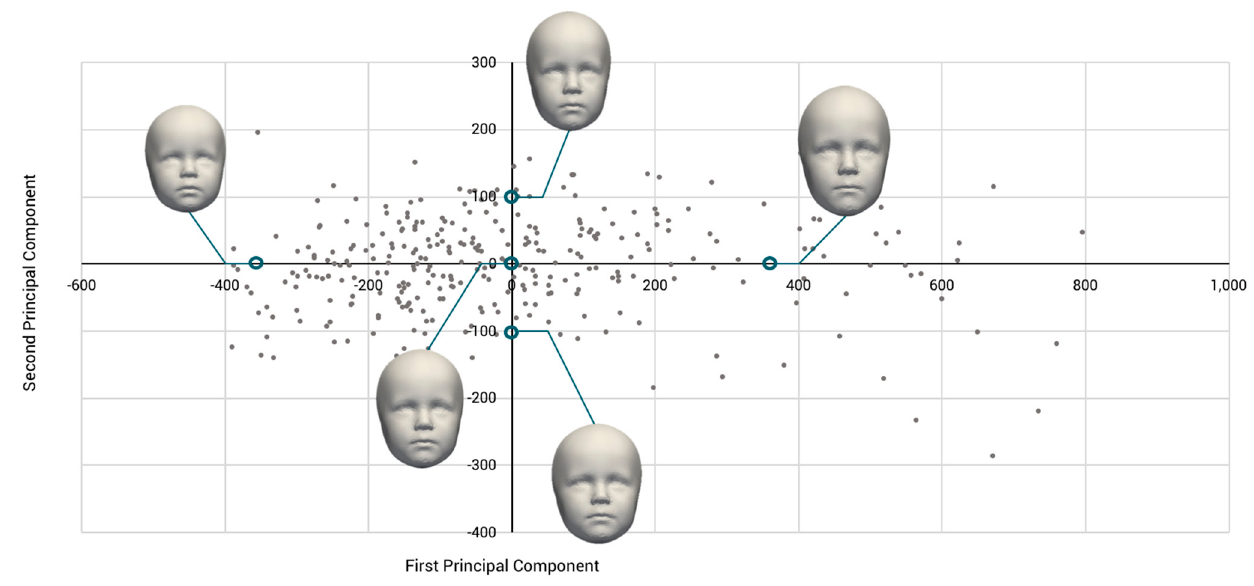
Figure 7. Scatterplot of shape based PCA including shape modes ( − 1.5 and +1.5 standard deviations).